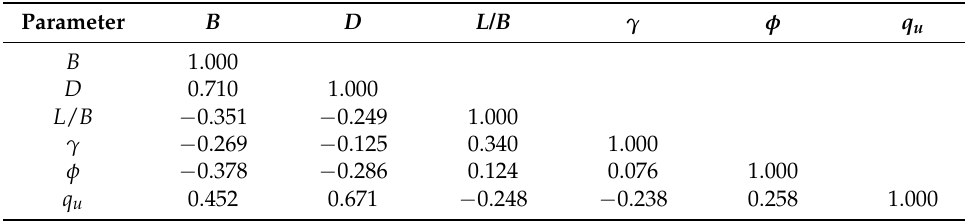
Table 3. Correlation coefficients between various